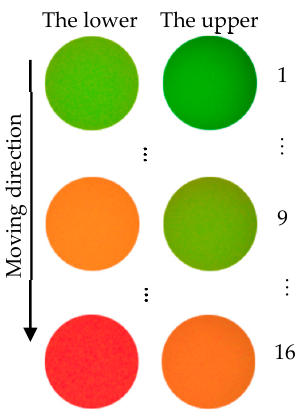
Figure 10. The color change of the calibration experiment. Table 2. Calibration result calculated using the data from the upper surface of the